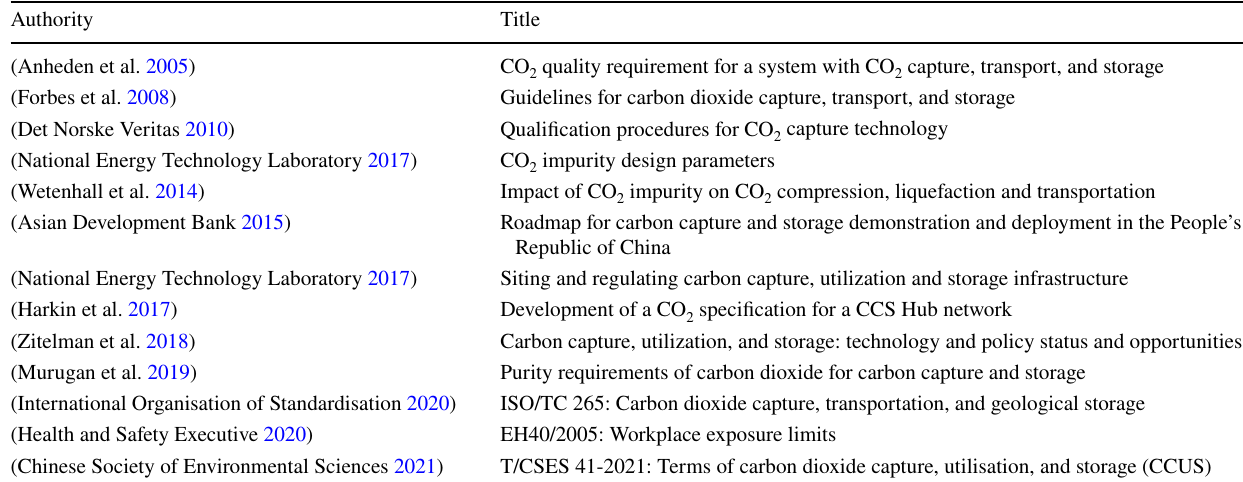
Table 1 Standard for CCUS by various authorities and ongoing projects Authority